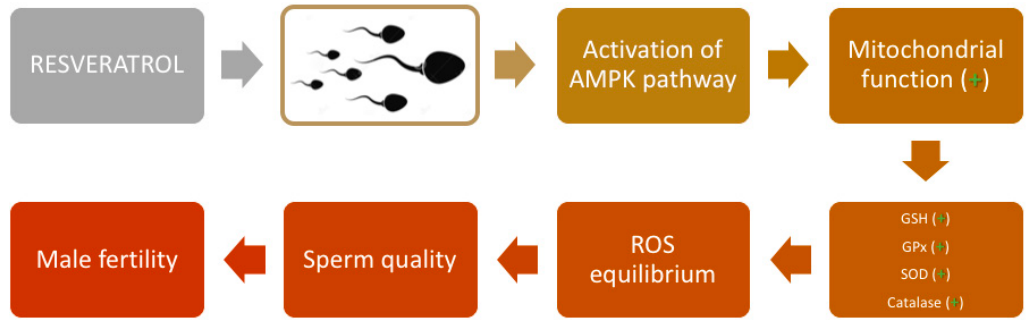
Figure 3. Mechanism of action of resveratrol in spermatozoa. Resveratrol activates the AMPK pathway, which is correlated with a higher mitochondrial function and higher activity of Glutathione (GSH), glutathione peroxidase (GPx), Superoxide dismutase (SOD), and catalase determining ROS equilibrium. These mechanisms protect against oxidative stress, ameliorating sperm quality and, thereby, fertility of the spermatozoa.